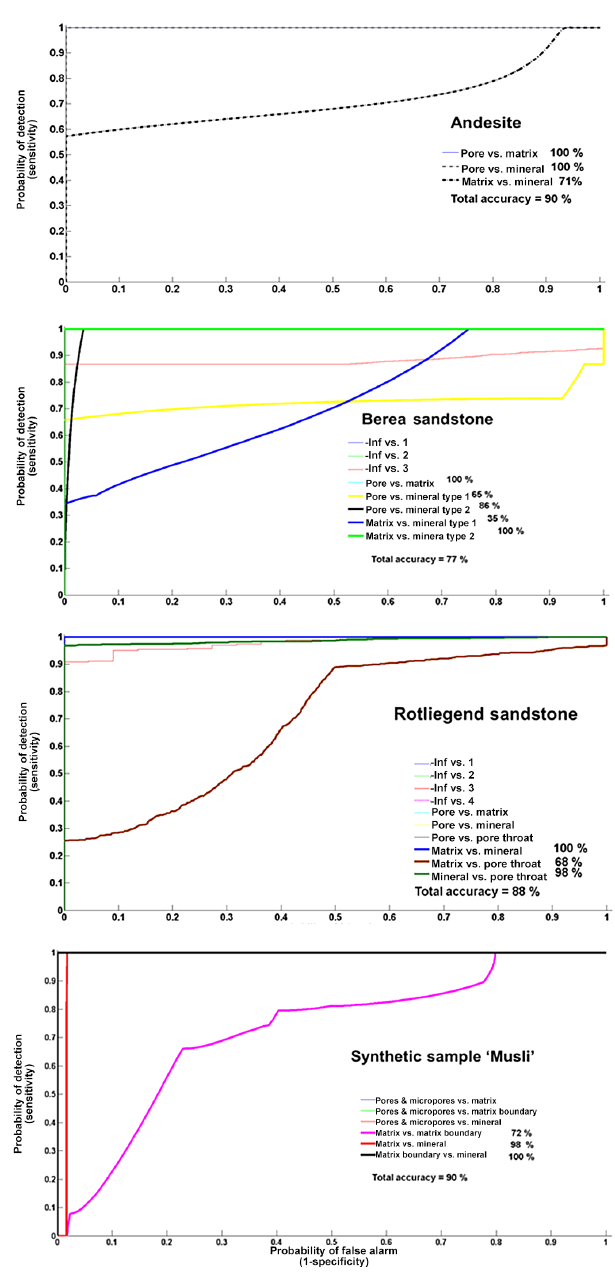
Figure 8. Receiver operational characteristic curves depicting the accuracy of the least-squares support vector machine multi- classification scheme for class four. A few curves which appear in the legend have close proximity to the x axis and lie behind other curves and therefore are